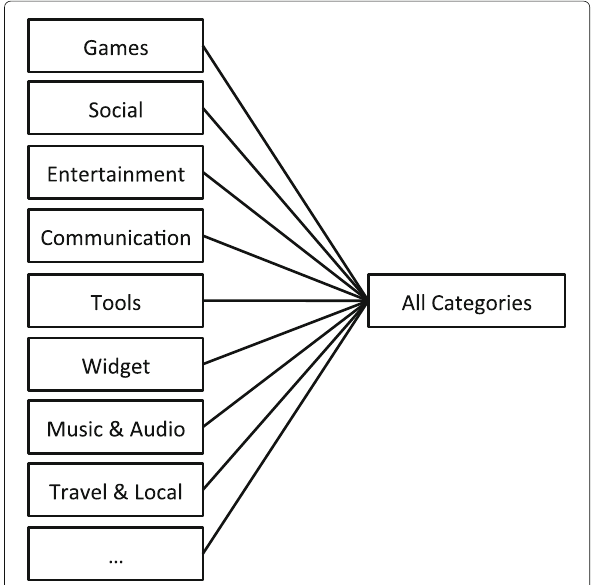
Fig. 4 Hierarchy of criteria for class